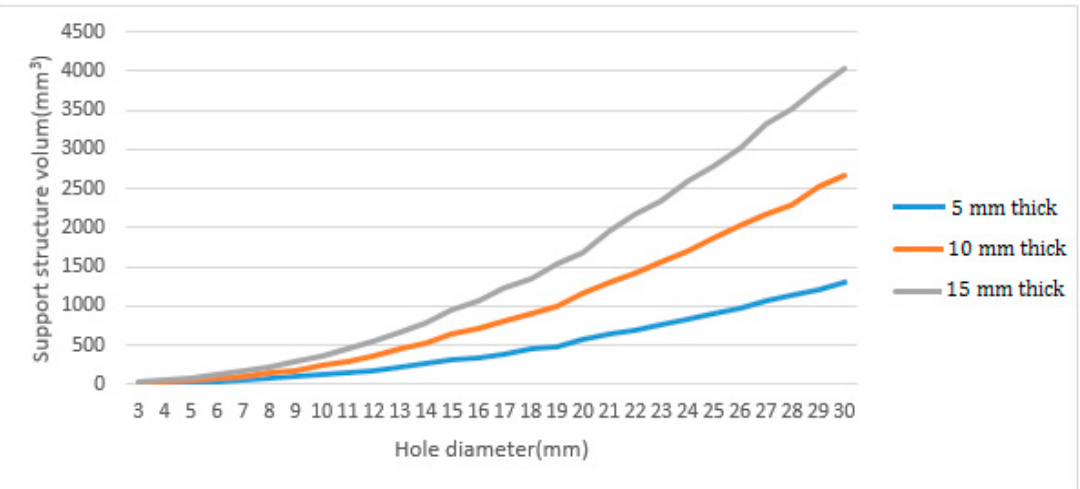
Figure 17. Relationship between support structure volume and hole diameter and thickness.